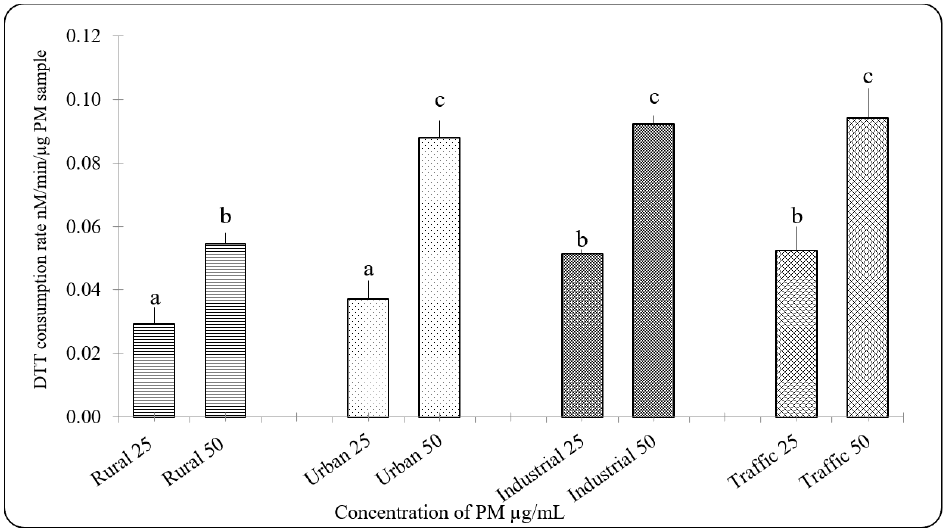
Figure 1. Oxidative potential of PM 2.5 measured by DTT assay, N = 3 ± SD. Dataset not sharing common superscript vary significantly p < 0.05 Duncan’s Multiple Range Test